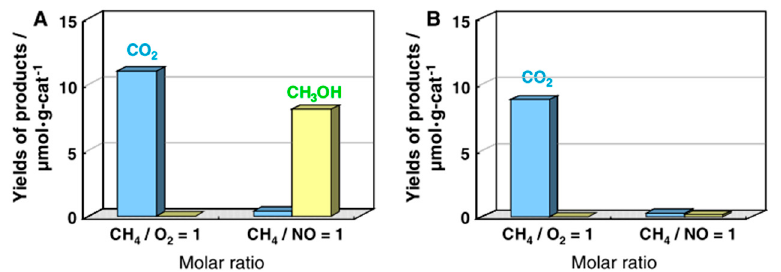
Figure 42. Yield of CO 2 and methanol using ( A ) vanadium-containing mesoporous silica (V-MCM-41) (acid) and ( B ) V-MCM 41 (base) with different oxidants. The amount of V was 0.6%, the reaction temperature was 295 K, and the reaction time was 3 h. Reprinted with permission from [56]. Copyright (2008), Springer Nature.